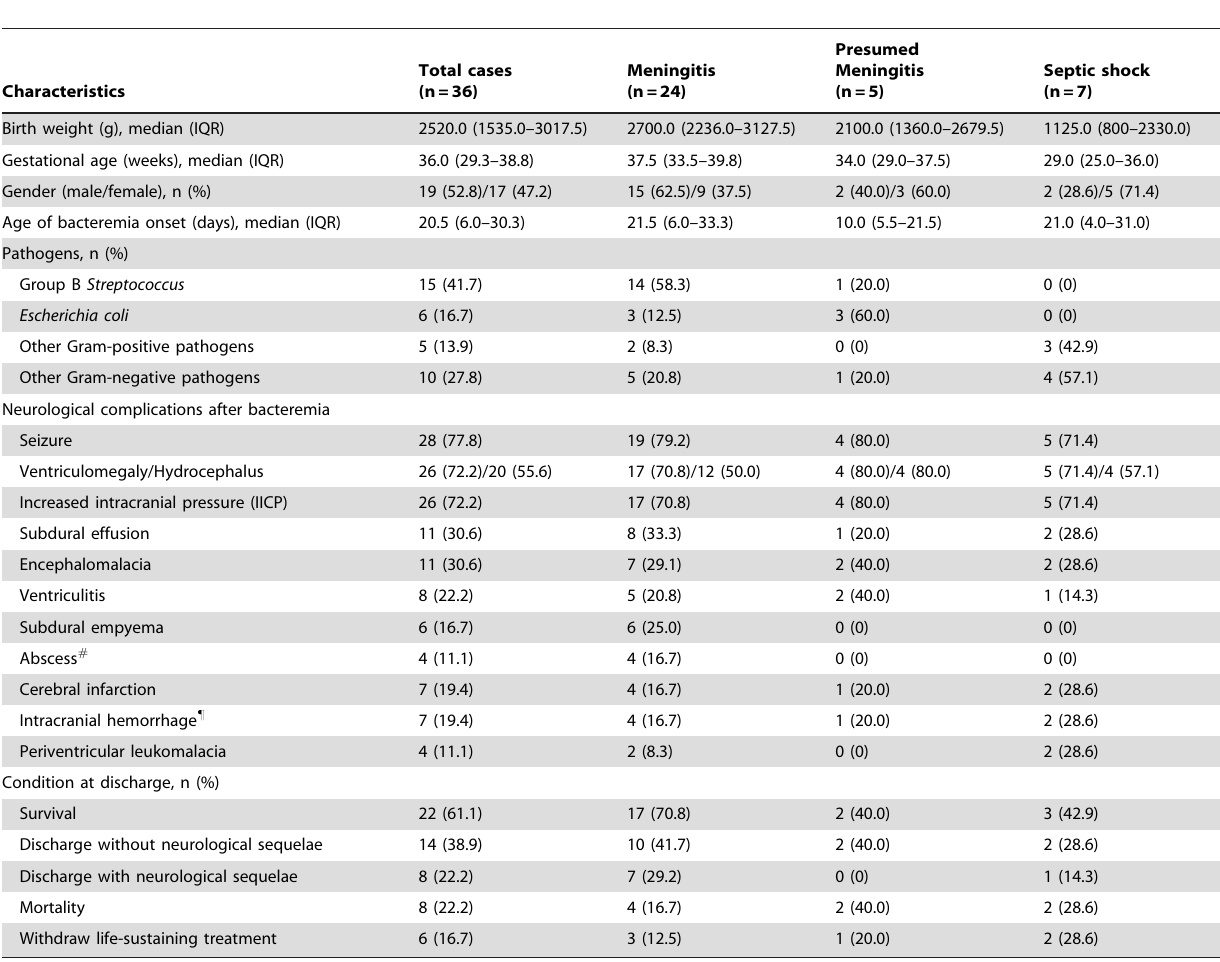
Table 2. Pathogens, clinical manifestations, and demographics of neonates with bacteremia-associated neurological